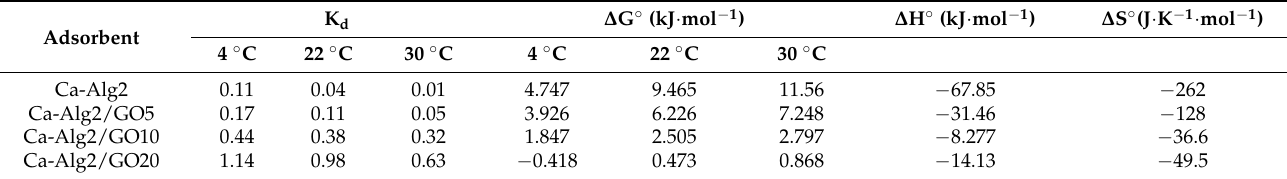
Table 2. Thermodynamic parameters for FMTD adsorption on Ca-Alg2, Ca-Alg2/GO5, Ca-Alg2/GO10 and Ca-Alg2/GO20 beads. Adsorbent